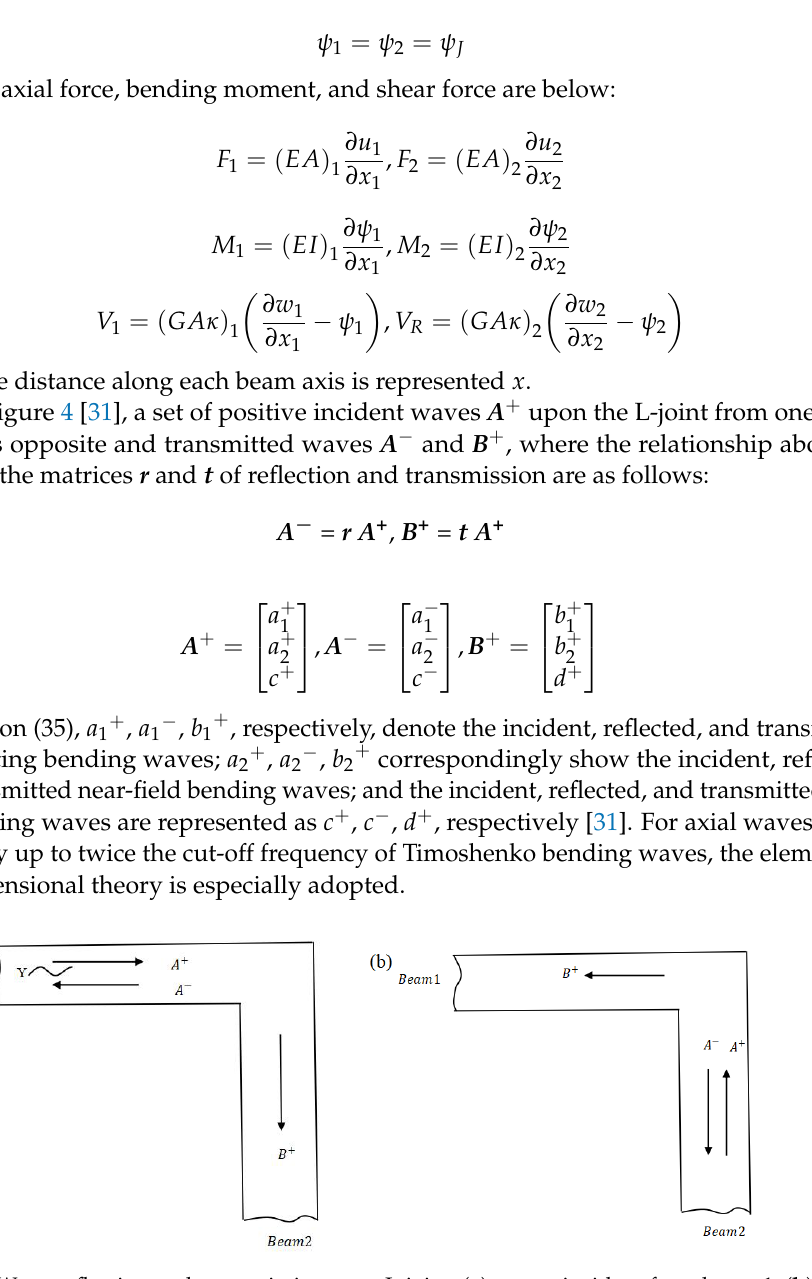
Figure 4. Wave reflection and transmission at an L-joint, ( a ) waves incident from beam 1, ( b ) waves incident from beam 2. (Reprinted with permission from Ref. [31]. 2012, ASME Publishing.).